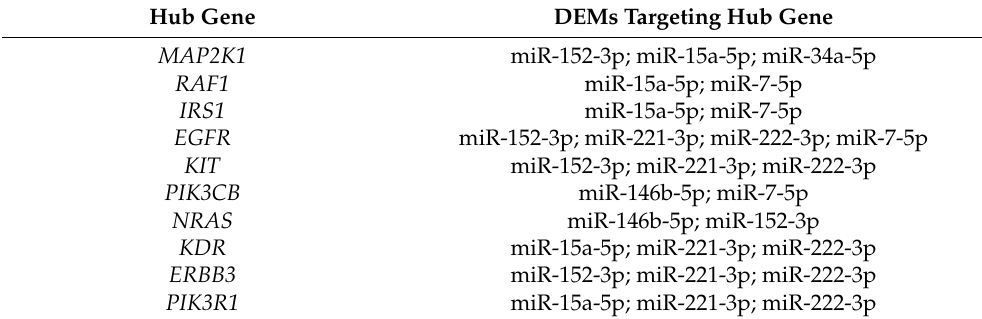
Figure 3. The networks of the top 10 hub genes. Table 3. Top 10 hub genes.